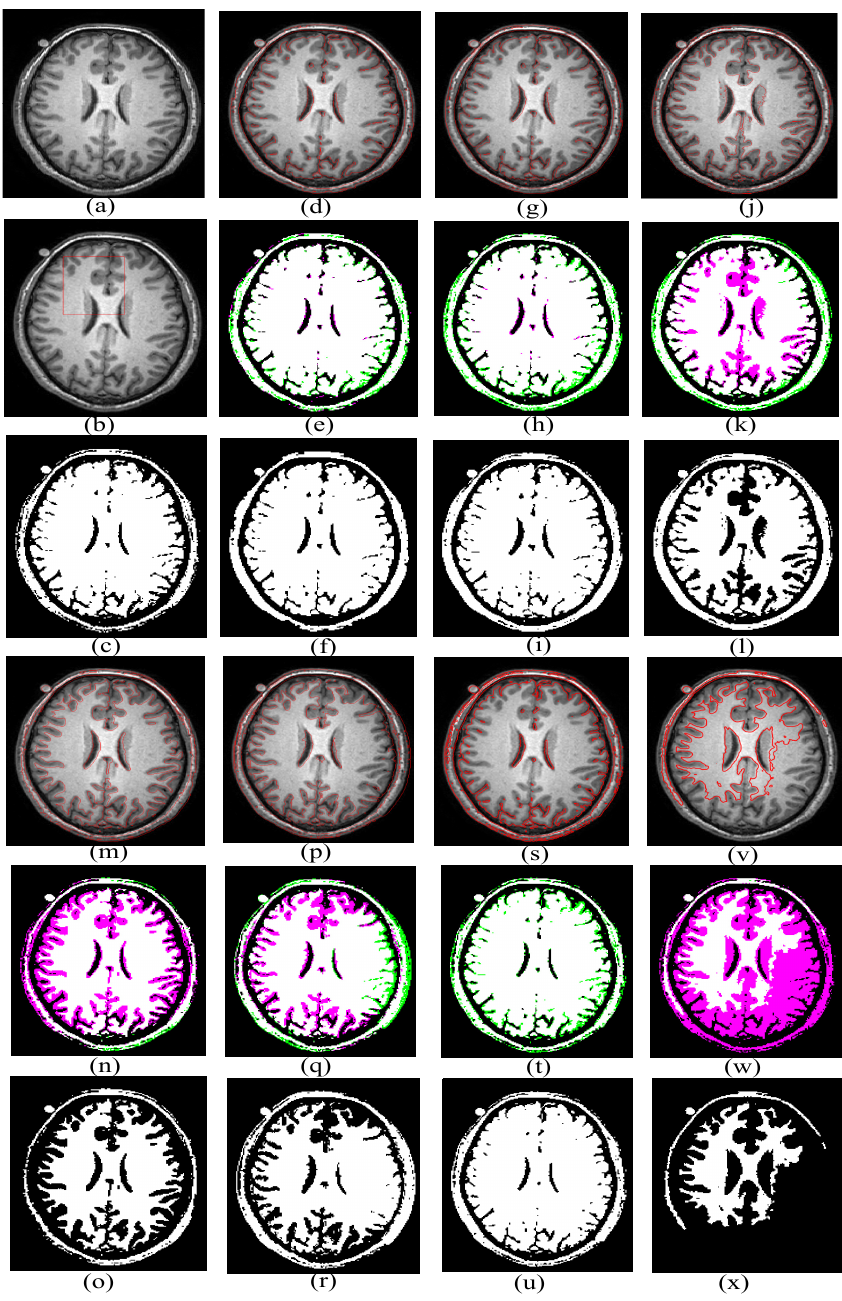
Figure 4. Performance of our method, the LIC model, the LBF model, 0.5-order, 1.5-order, the CV model and the ALFB model. ( a ) Original image; ( b ) the original image with the initial contour; ( c ) the ground truth of the original image; ( d ) the segmentation result of our method; ( e ) the com- parison map of our method; ( f ) the ground truth of our method; ( g ) the segmentation result of LIC model; ( h ) the comparison map of LIC model; ( i ) the ground truth of LIC model; ( j ) the segmentation result of LBF model; ( k ) the comparison map of LBF model; ( l ) the ground truth of LBF model; ( m ) the segmentation result of 0.5-order; ( n ) the comparison map of 0.5-order; ( o ) the ground truth of 0.5-order; ( p ) the segmentation result of 1.5-order; ( q ) the comparison map of 1.5-order; ( r ) the ground truth of 1.5-order; ( s ) the segmentation result of CV model; ( t ) the comparison map of CV model; ( u ) the ground truth of CV model; ( v ) the segmentation result of ALFB model; ( w ) the comparison map of ALFB model; and ( x ) the ground truth of ALFB